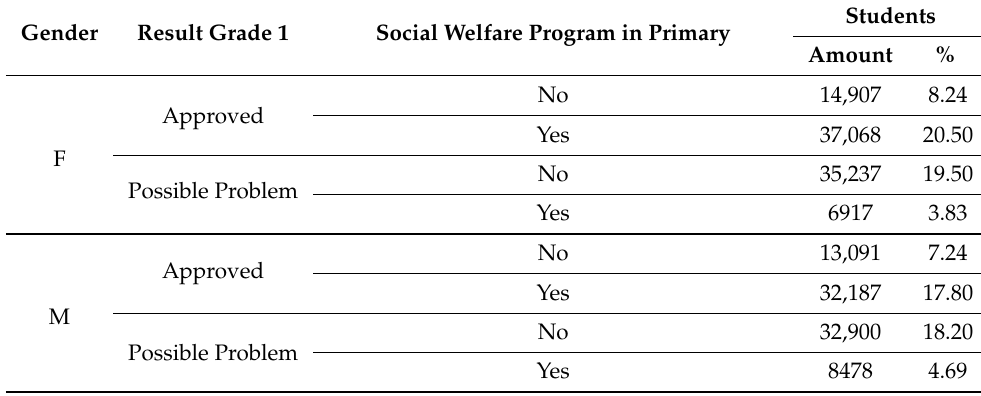
Table 3. Percentages of students with benefits in primary school considering gender and problem- atic situations.